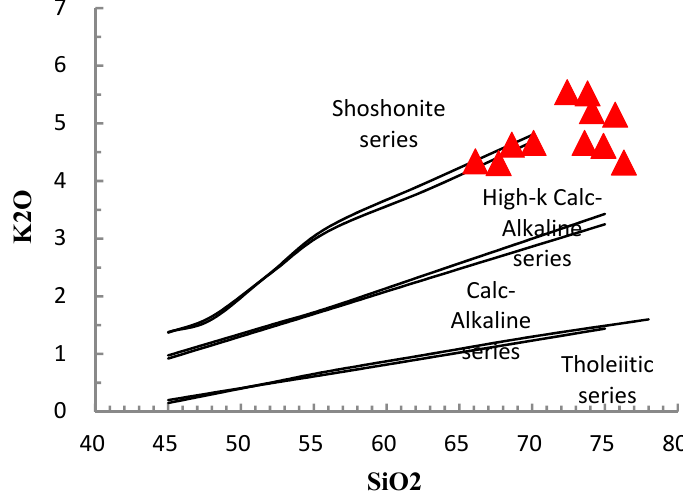
Figure 12. Granite-class diagram of SiO 2 –K 2 0 (Peccerillo [28]).